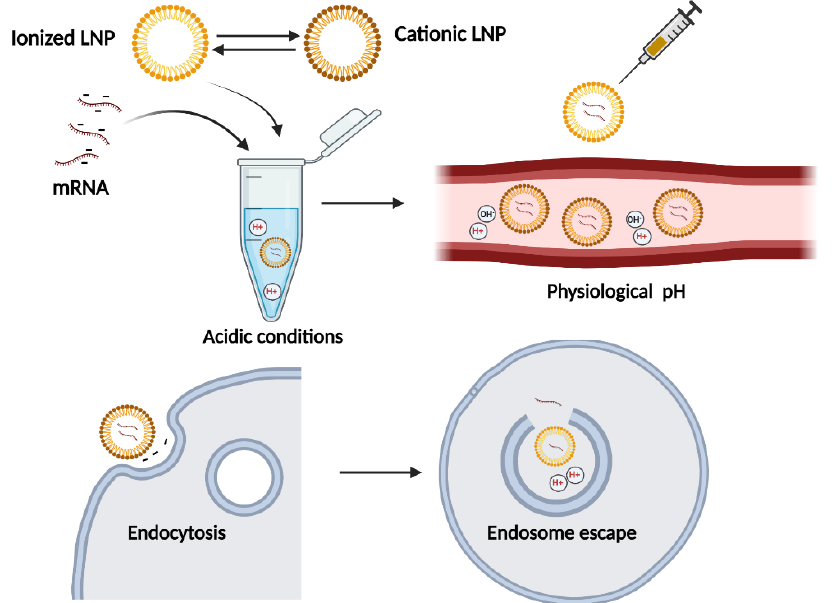
Figure 2. Lipid nanoparticles ’ ionizable lipid component facilitates the delivery of mRNA cargo. The transition of LNPs between positive and neutral charges from the mRNA loading step to the final release to the cell cytoplasm is shown. In acidic condition, ionizable lipids are